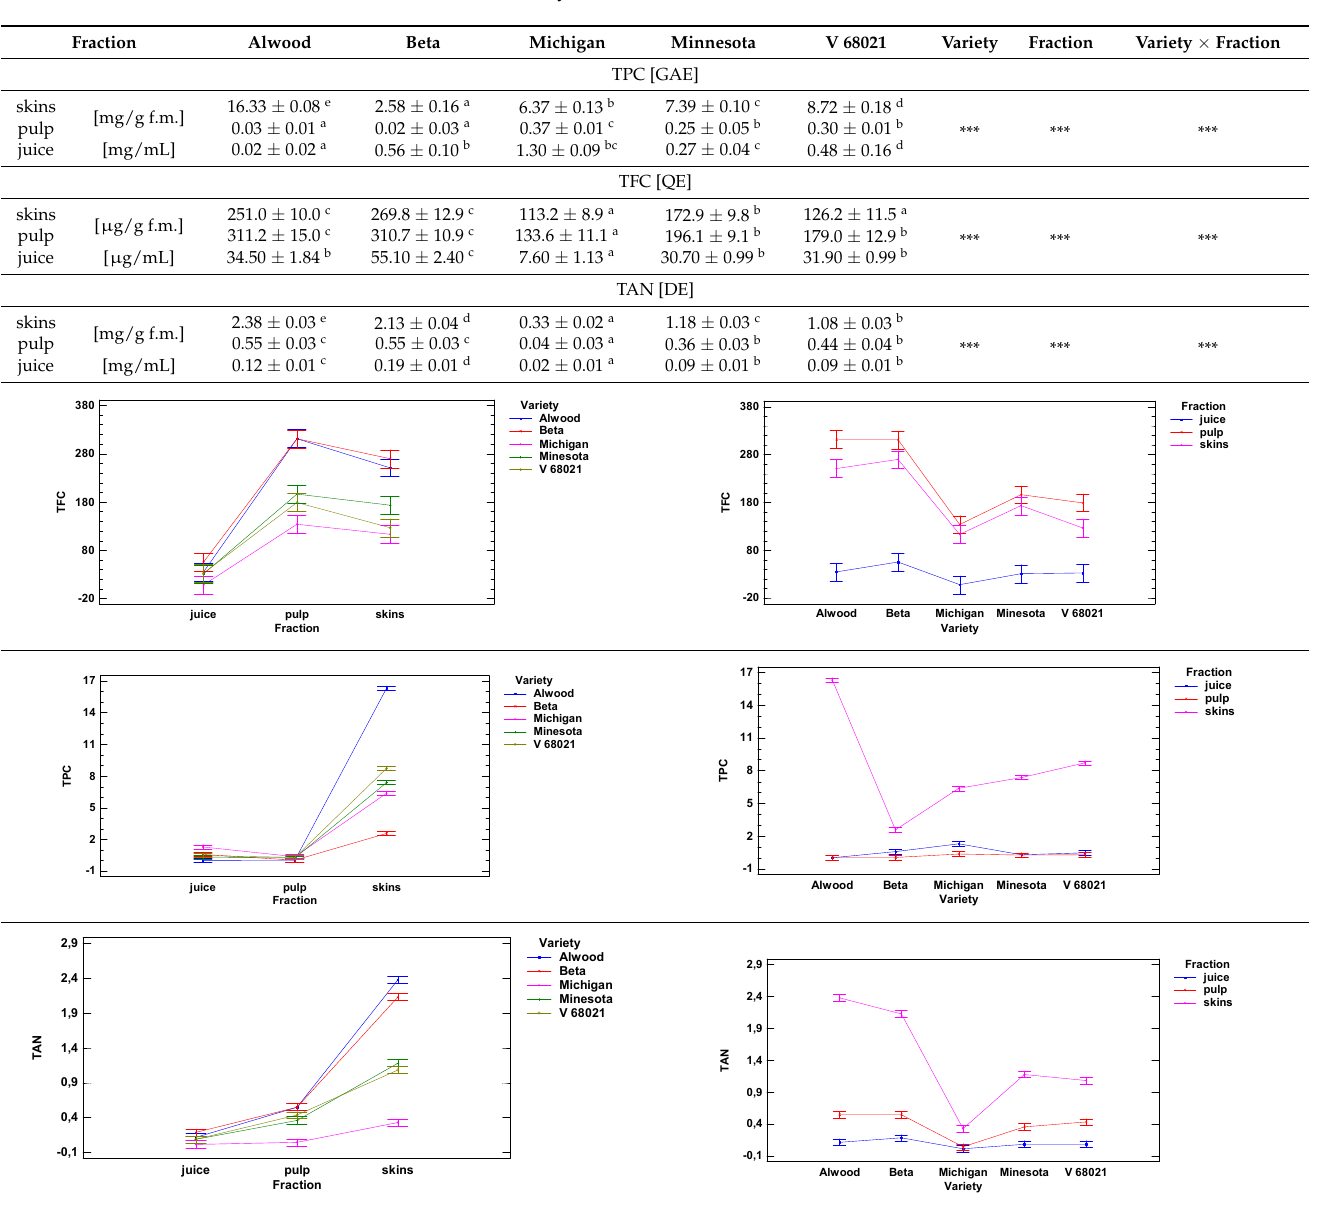
Table 3. Equivalents content for polyphenolic compounds, flavonoids and anthocyanins in skins, fruit pulp and juice of the studied Vitis hybrid grape cultivars grown in the Rzeszów Podgórze area (in the Lower San Valley) in Poland.